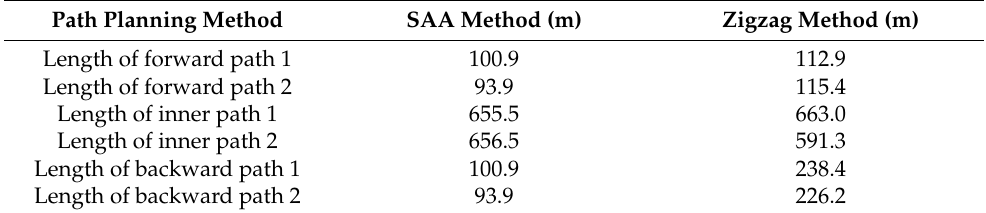
Table 3. Path lengths of different parts.